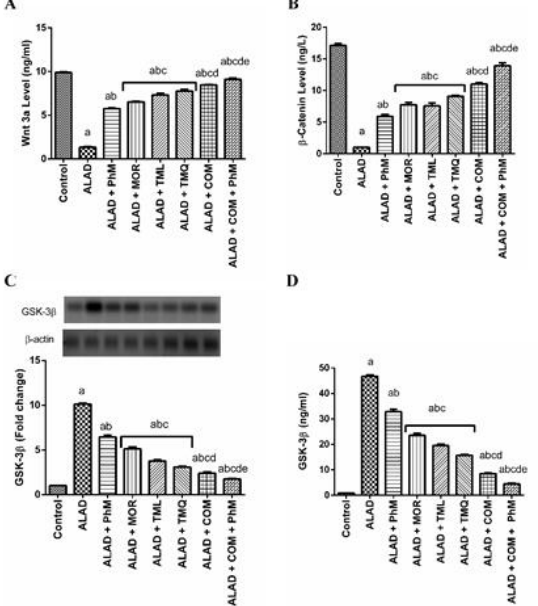
Figure 8. The effect of phytochemicals combination, MOR, TML, and TMQ, with PhM on Wnt3/β - catenin/GSK- 3β signaling in AD. ( A ) Wnt3a levels, ( B ) β -catenin level, ( C ) Folds of GSK- 3β protein expression, and ( D ) GSK- 3β levels. The data are presented as means ± SD ( n = 7). Significance (a): relative to the control group. Significance (b): relative to the ALAD group. Significance (c): relative to ALAD + PhM group. Significance (d): relative to either ALAD + MOR, ALAD + TML, or ALAD + TMQ group. Significance (e): relative to ALAD + COM group Significance: p < 0.05. The data of the effect of MOR, TML and TMQ on the control are not shown as they were not significant.